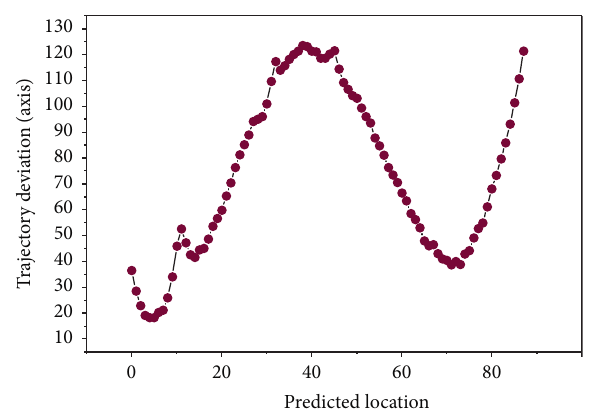
Figure 21: MAE scatter plot for right-turn trajectory prediction.